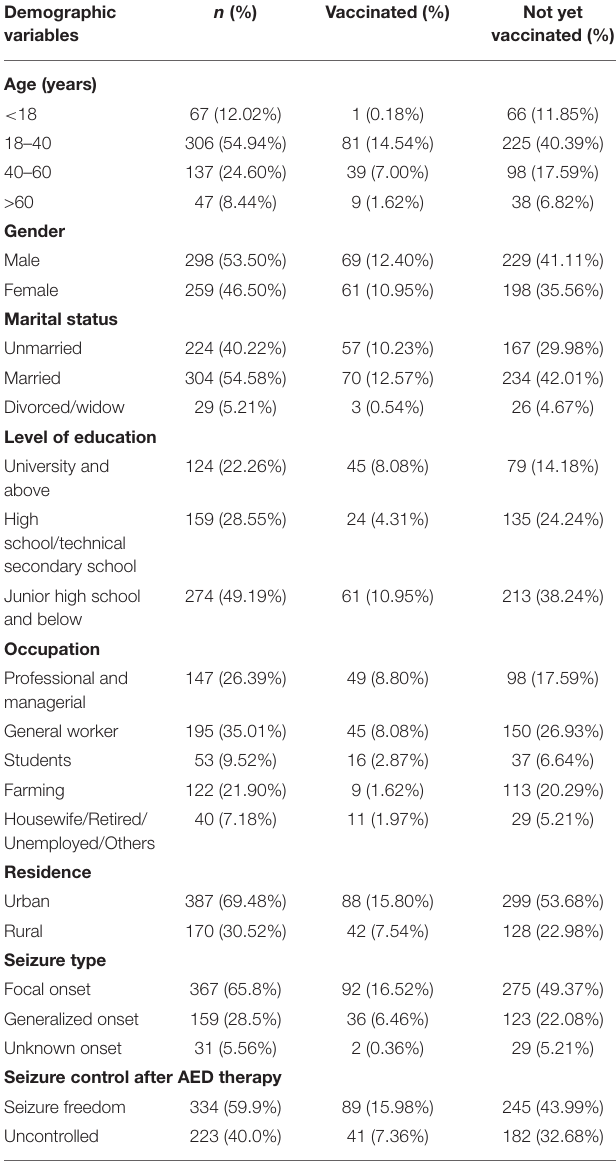
TABLE 1 | Characteristics of survey participants ( n =